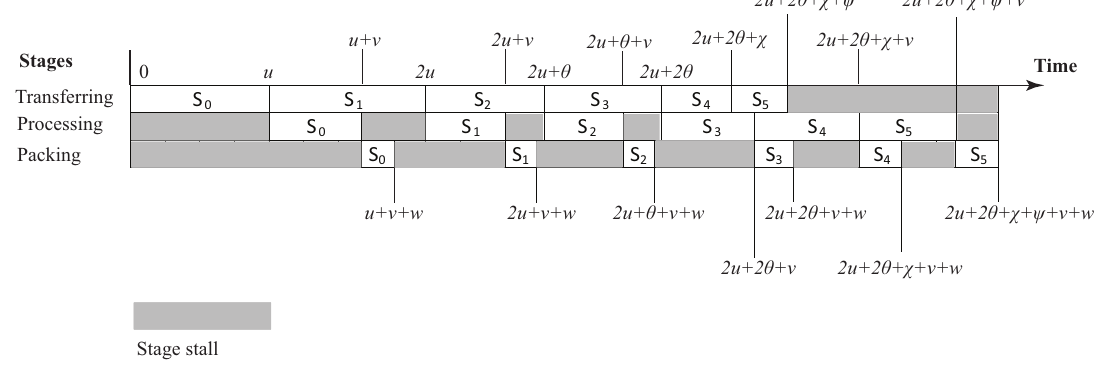
Figure 2. Pipelined scheduling, u > v > w